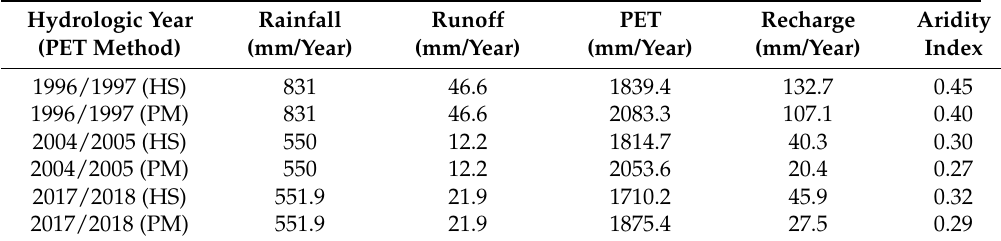
Table 11. Rainfall, PET, and Recharge for 1996/1997, 2004/2005, and 2017/2018 hydrological years for the Singida